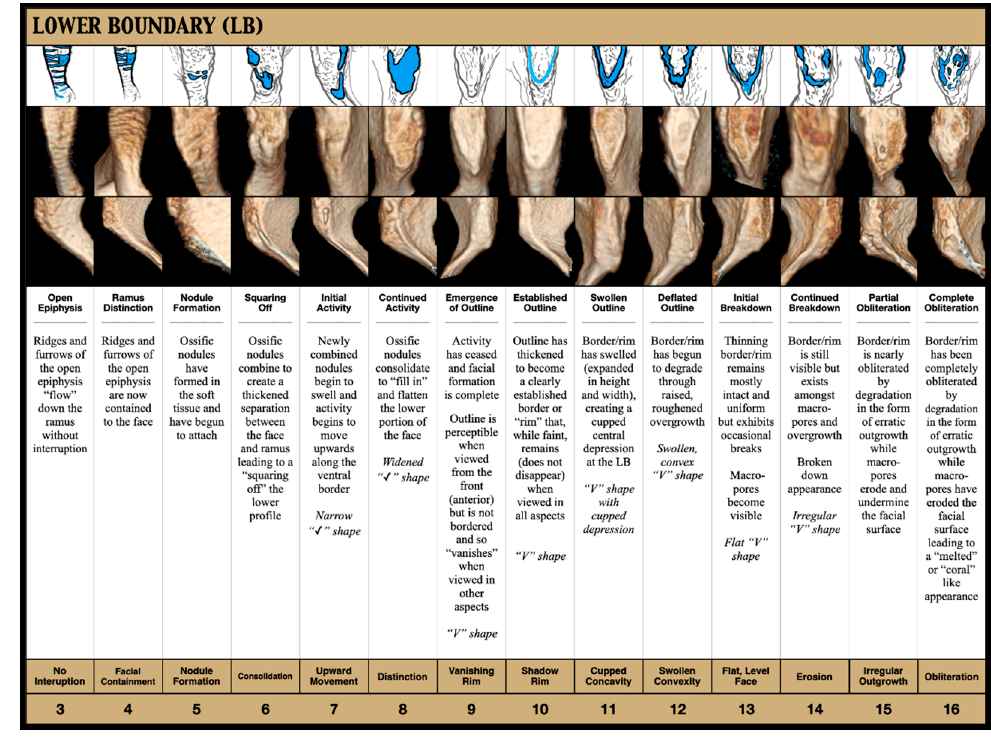
Figure 5. Guide to the Lower Boundary.